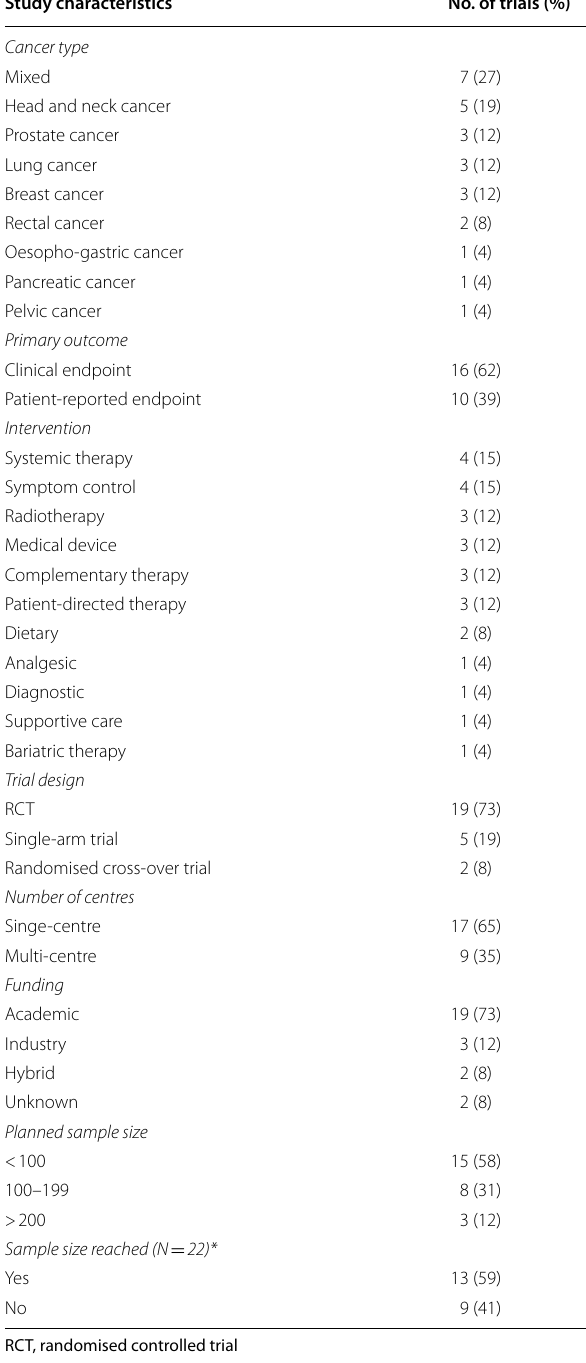
Table 1 Baseline study characteristics (n